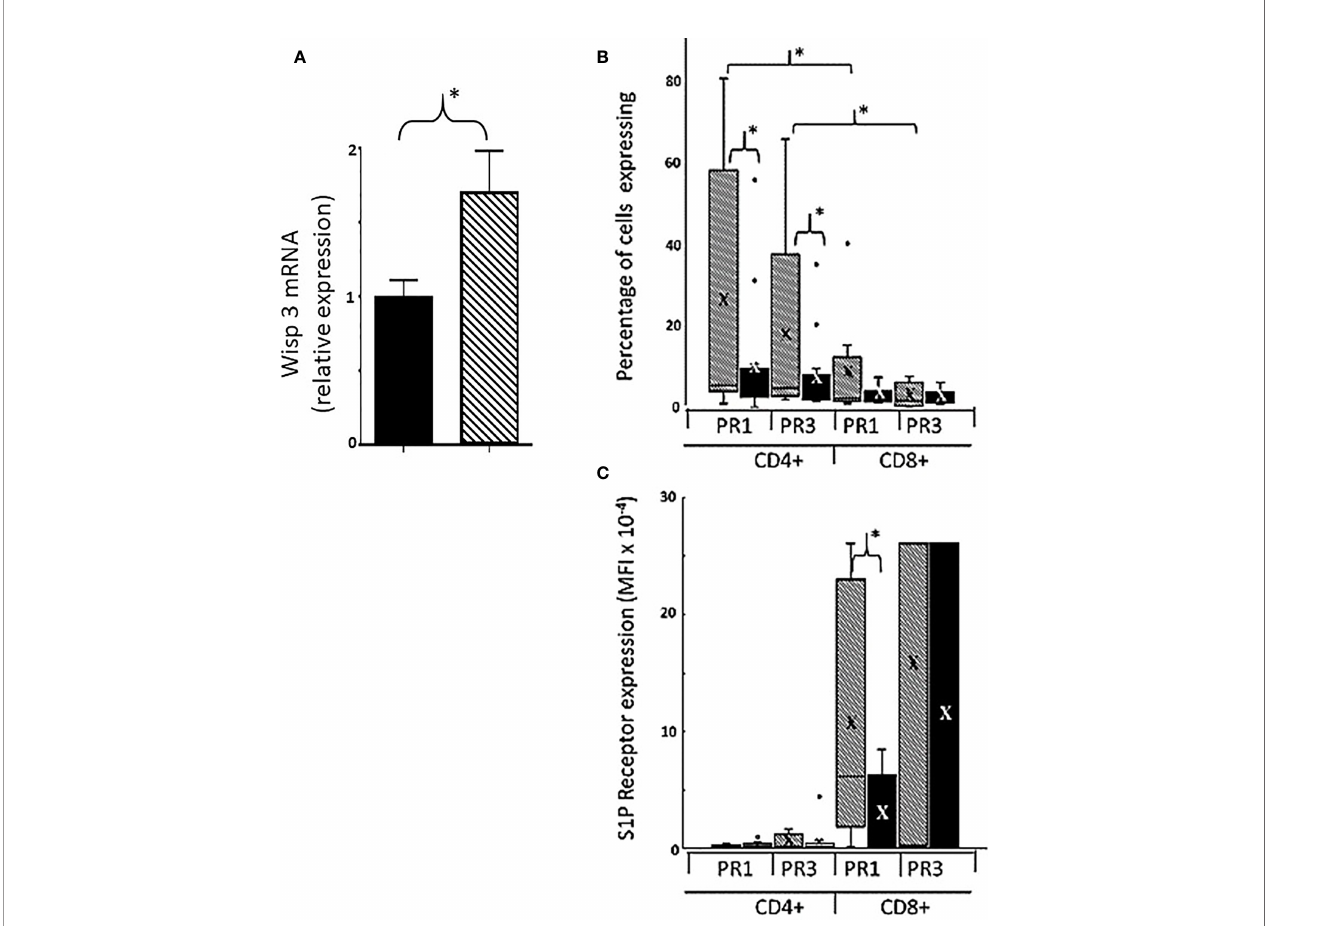
FIGURE 12 | Sexually dimorphic expression of thymic Wisp3 mRNA and Expression of type 1 and 3 receptors for sphingosine-1-phosphate on CD4+ and CD8+ cells from postnatal day 7 FCG pup thymi. RNA from thymic epithelium/stroma of male and female FCG mice at post-natal day 7 was analyzed for Wisp3 mRNA expression by RT-QPCR (A) . Data are presented as relative mRNA expression normalized to GAPDH and setting the male value as 1. n = 8 males (both XXM and XYM, solid bar) and 8 females (both XXF and XYF, cross-hatched bar). *p < 0.05. Percentage of cells expressing either S1PR1 or S1PR3 (B) and mean fl uorescence intensity for these receptors (C) . Data are shown as box and whisker plots. X= mean. n = 11 females and 13 males. Males includes both XYM and XXM (solid bars) and females includes both XXF and XYF (cross-hatched bars). *p <0.05. Effect size for CD8+PR1 MFI in males versus females (C) is